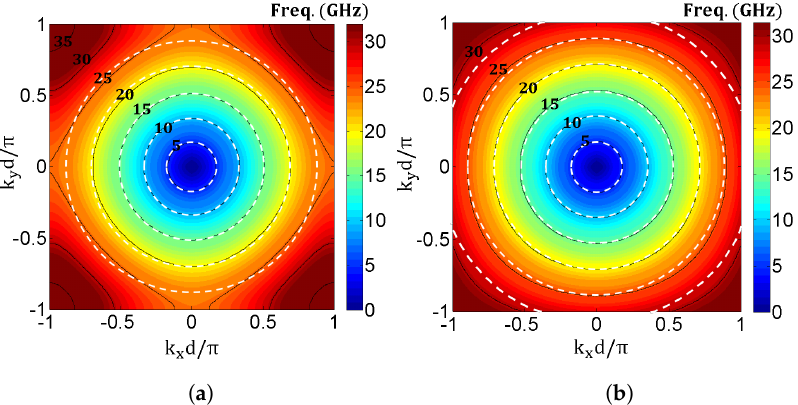
Figure 7. Isofrequency plot for the ( a ) mirror-symmetric and ( b ) glide-symmetric configurations. To compare the isotropy level, perfect circles are marked in white. The geometrical parameters of the unit cells are: g = 0.2mm, h t = 3mm, h hole = 1.5mm, and d x = d y =